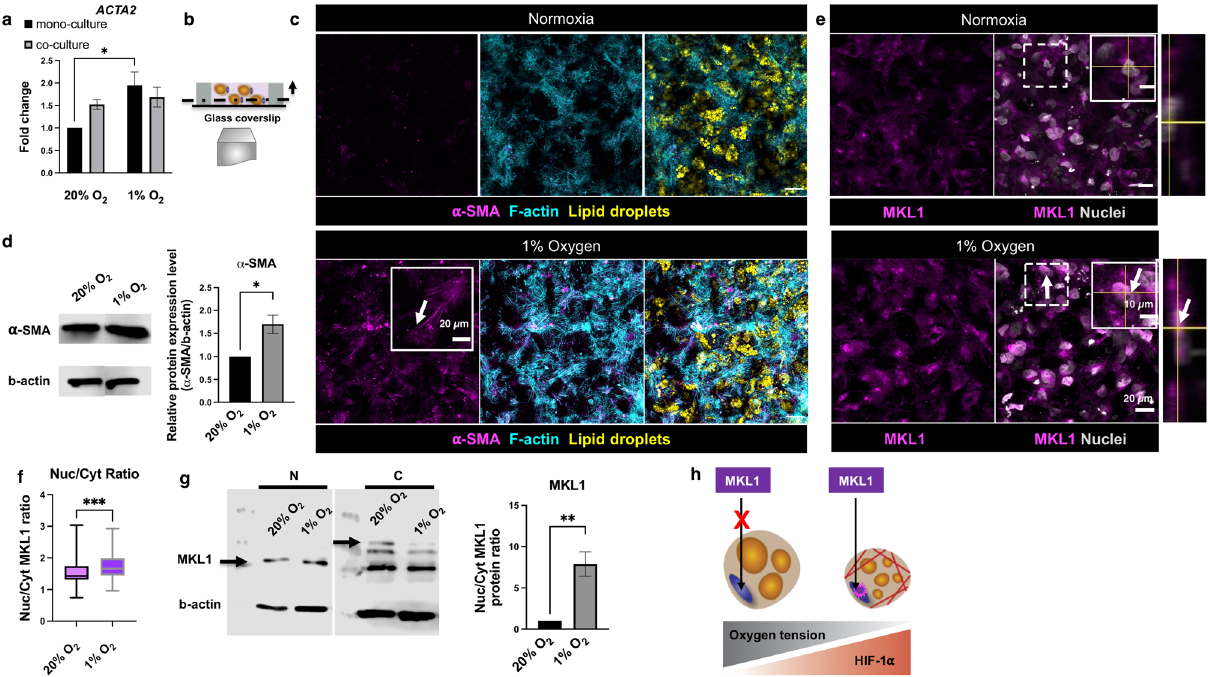
Figure 4. Hypoxia induces stress fiber formation through MKL1 nuclear translocation. ( a ) ACTA2 was significantly upregulated in hypoxia (n = 8 biological replicates). ( b ) Cross-section of AT constructs, fluorescent confocal microscopy images were taken at least 20 µm above the glass coverslip. ( c ) Fluorescent confocal microscopy images of the mono-culture AT constructs after 7 days in normoxia (top left panel) and 1% oxygen (bottom left panel), arrows point to ⍺ -SMA signal and stress fiber morphology (scale bar-50 µm, insets-20 µm). ( d ) ⍺ -SMA protein expression was significantly increased in 1% oxygen (data are presented for the mono-culture condition, cropped blot is shown, full length blot is presented in Supplementary Fig. S5). ( e ) Fluorescent confocal microscopy images of the mono-culture AT constructs and the orthogonal view in normoxia (top right panel) and 1% oxygen (bottom right panel), arrows point to MKL1 signal localization (scale bar- 20 µm, insets- 10 µm). ( f ) Nuclear to cytoplasmic ratio for MKL1 was significantly increased in 1% oxygen (n = 5 biological replicates, 20 cells per replicate). ( g ) MKL1 nuclear (N) to cytoplasmic (C) protein ratio was significantly increased in 1% oxygen, arrows point to the quantified MKL1 protein bands (data are presented for the mono-culture condition, n = 3 biological replicates, cropped blot is shown, full length blot is presented in Supplementary Fig. S6). ( h ) Hypoxia induces actin stress fiber formation via MKL1 nuclear translocation. Data are presented as means ± SEM. Comparisons between groups and statistical analysis were performed